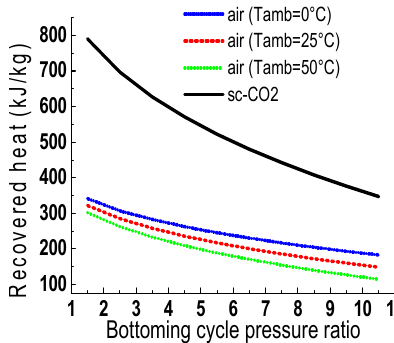
Figure 6. Bottoming compressor work ( a ) and turbine work ( b ) versus bottoming cycle pressure ratio with air at different ambient temperatures and with sc-CO 2 .